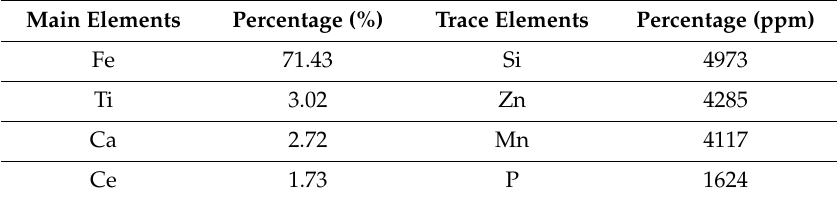
Elemental composition of the TWP determined by X-ray fluorescence spectroscopy (XRF)